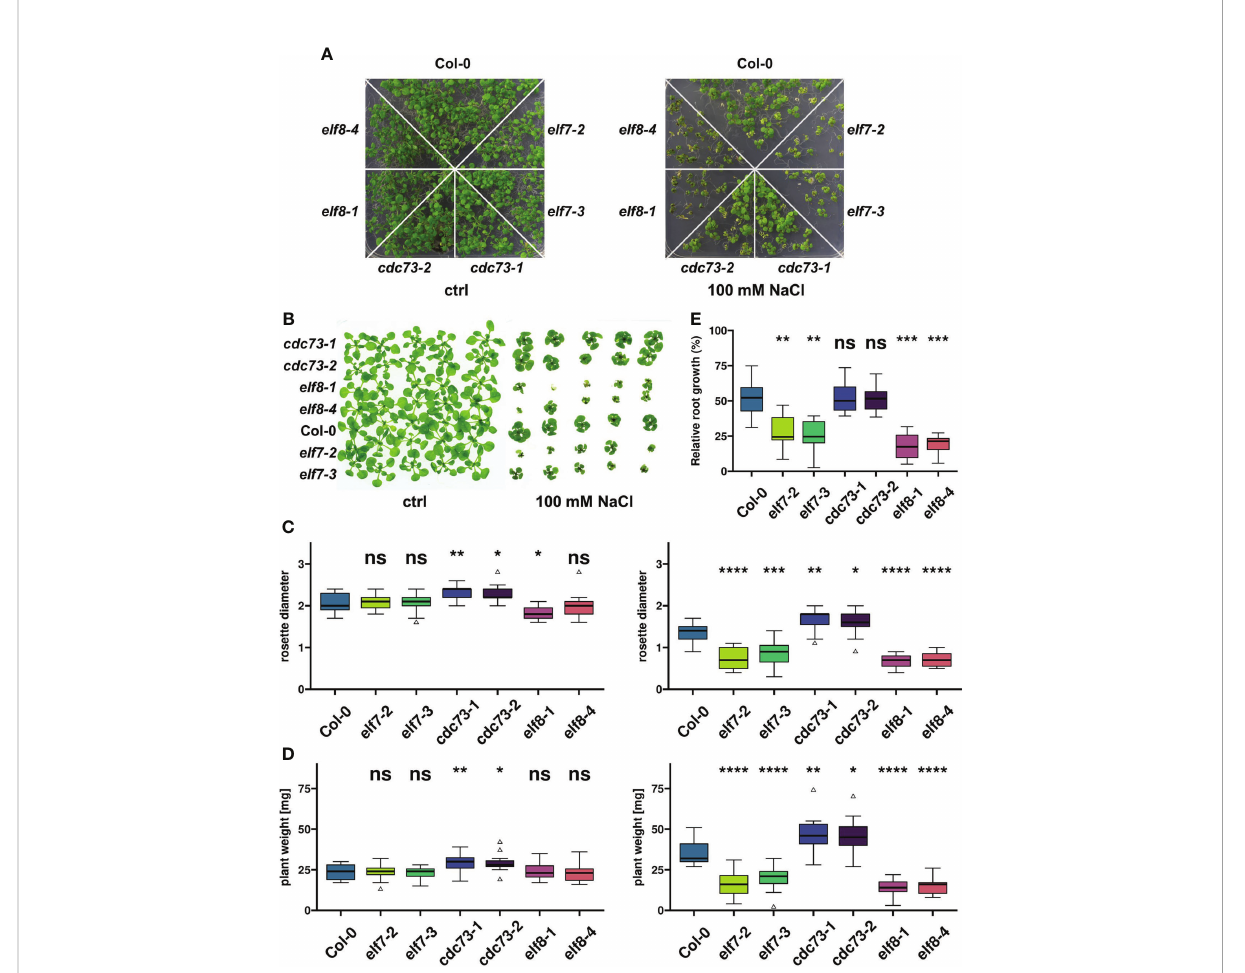
FIGURE 1 Growth of PAF1C subunit mutants is differentially affected by exposure to elevated NaCl concentrations. (A) Seeds of the indicated genotypes were sown on solid MS medium containing 100 mM NaCl or control medium (ctrl), and the resulting plants were documented at 14 days after strati fi cation (14 DAS). (B) After growth on solid MS medium for 7 DAS, plants of the indicated genotypes were transferred to control medium or to medium containing 100 mM NaCl. Plants were documented after additional 18d (ctrl) or 21d (100 mM NaCl) of growth. (C, D) 7 DAS plants were grown in absence or presence of 100 mM NaCl for another 11d (ctrl, left) or 14d (100 mM NaCl, right), before rosette diameter [cm] (C) or fresh weight [mg] (D) was determined (n = 15). (E) Plants were grown on vertical MS plates for 7 DAS, before they were transferred to control medium or medium containing 100 mM NaCl. Length of the primary roots was recorded directly after transfer (0h) and 96h after transfer (n = 8). Growth after 96h in presence of NaCl is depicted as percentage of growth of the same genotype on control medium. The relative growth of each genotype was compared to Col-0 using Wilcoxon signed-rank test (ns, not signi fi cant; *, p ≤ 0.05; **, p ≤ 0.01; ***, p ≤ 0.001; ****, p ≤